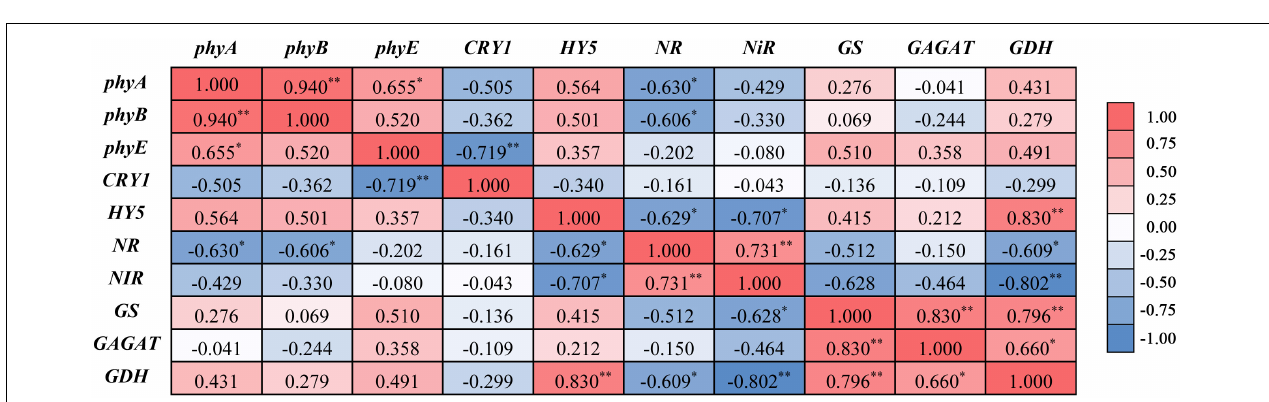
FIGURE 5 | Effects of spectra on genes relative expression level of light-response and nitrogen metabolism in lettuce leaves. (A) Relative expression level of NR . (B) Relative expression level of NIR . (C) Relative expression level of GS . (D) Relative expression level of GOGAT . (E) Relative expression level of GDH . (F) Relative expression level of phyA . (G) Relative expression level of phyB . (H) Relative expression level of phyE . (I) Relative expression level of CRY1 . (J) Relative expression level of HY5 . RB, 75% red + 25% blue LED; RBG, 60% red + 20% blue + 20% green LED; RBP, 60% red + 20% blue + 20% purple LED; RBF, 60% red + 20% blue + 20% infrared LED. The letters represent the significant difference of different treatments ( p < 0.05).